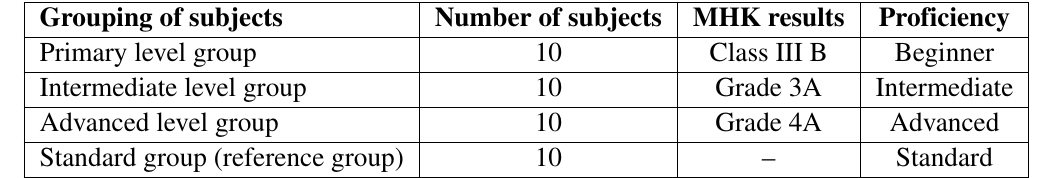
Table 1 Details of subjects’